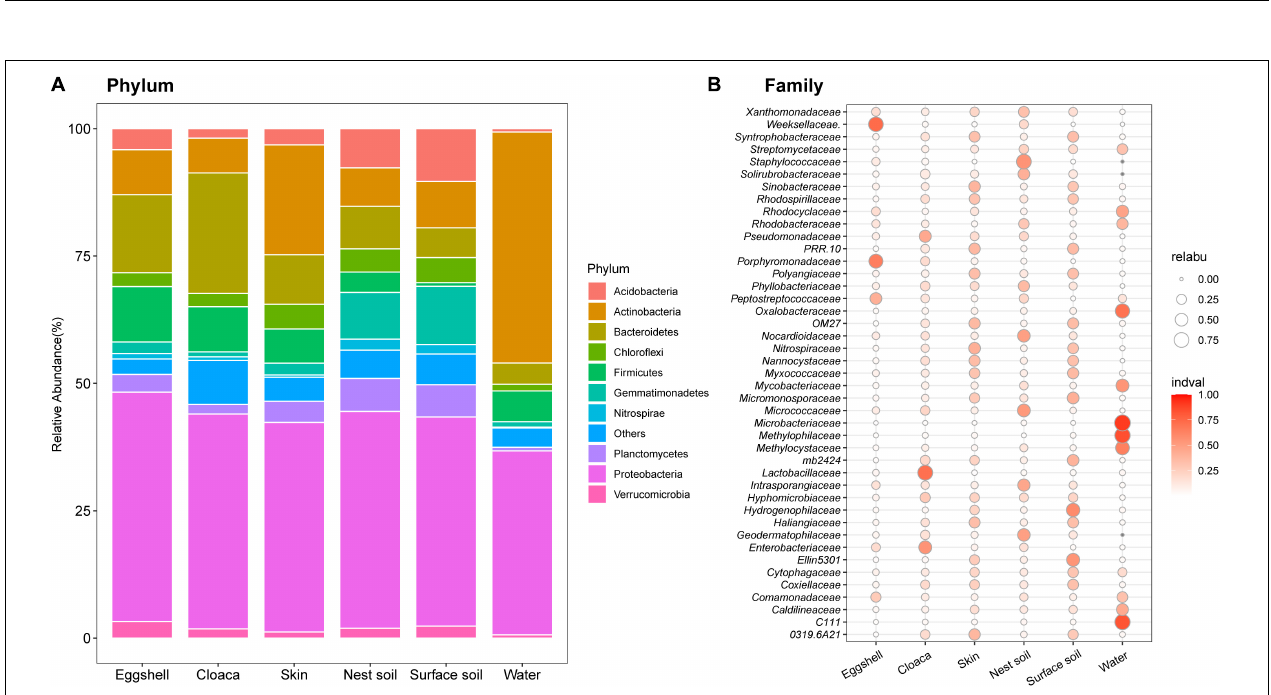
FIGURE 3 | Compositions of bacterial communities from eggshells and potential sources. (A) The 10 most abundant phyla among eggshells and maternal and environmental sources. Different colored portions of the bars represent the relative abundance of a given phylum for each group. (B) Indicator analysis across all sample types at the family level, after removing species with average abundance < 0.1% in eggshells. The size of the bubble represents the relative abundance, and the color intensity indicates the specificity of the species in the sample